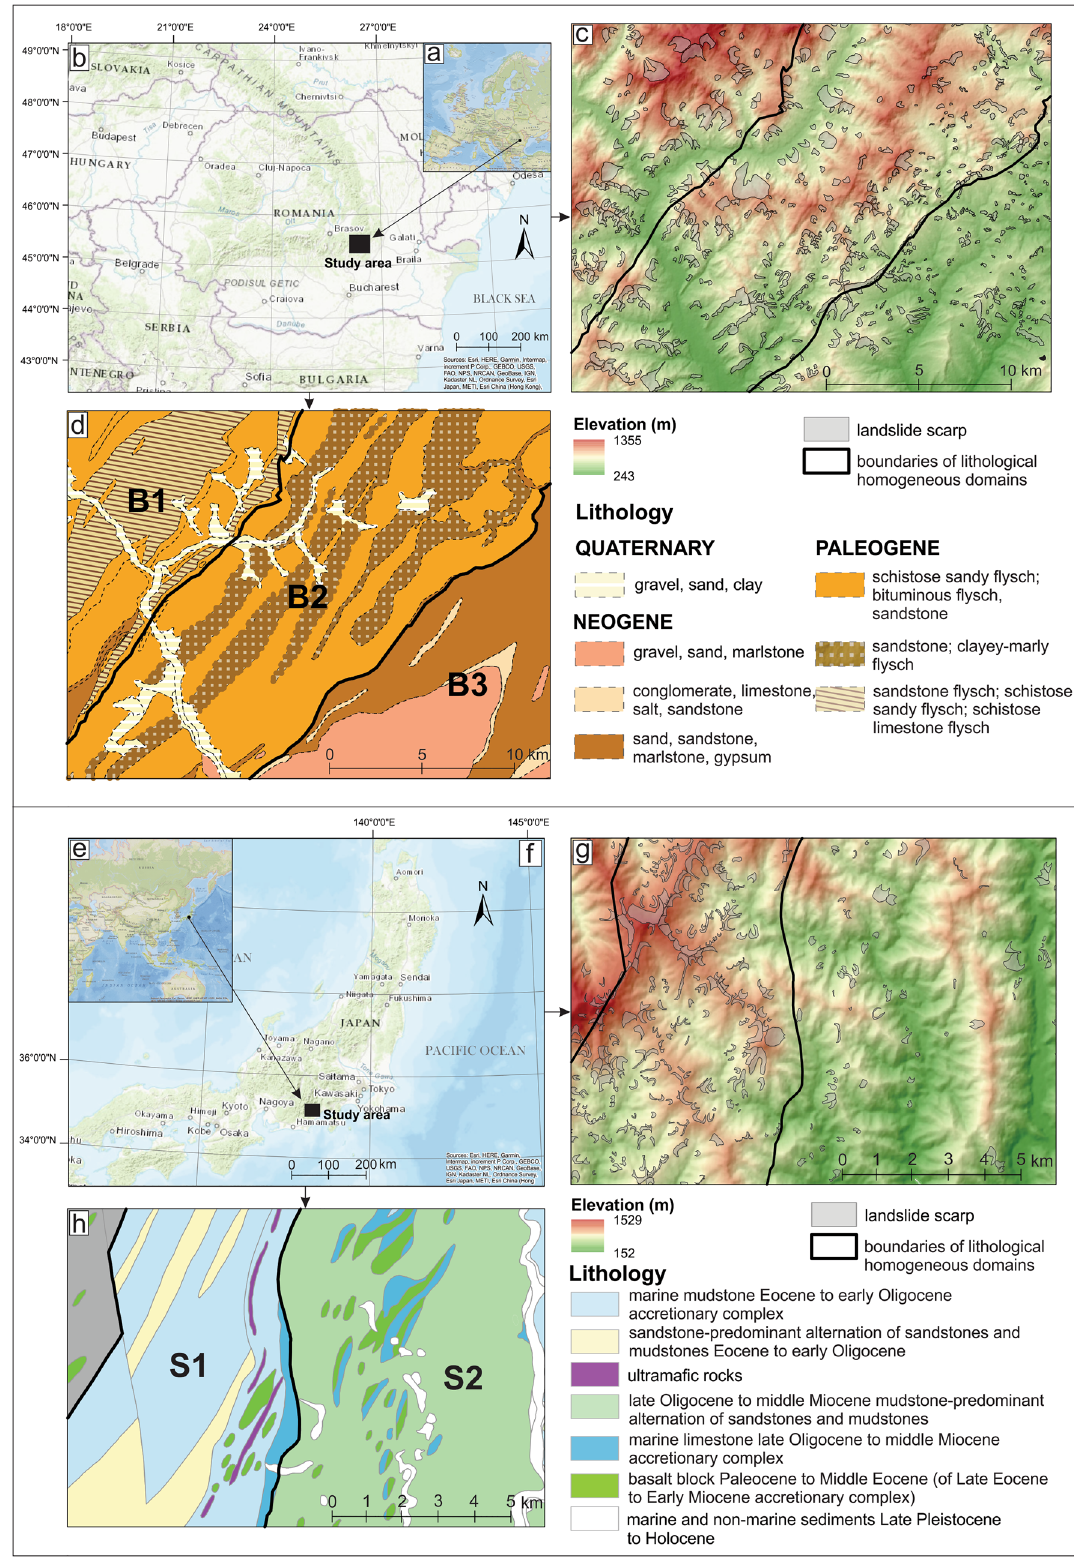
Figure 1. Location of Buzău ( a , b ) and Shizuoka ( e , f ) study areas. Lithologically-heterogeneous study areas are shown in ( c ) and ( g ) Lithologically-homogeneous domains are shown in ( d ) and ( h